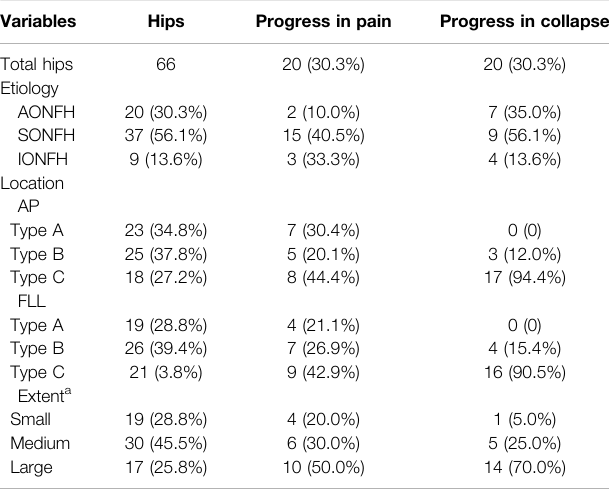
TABLE 1 | Fate of ARCO stage II ONFH patients according to the etiology and location/extent of necrotic lesion.